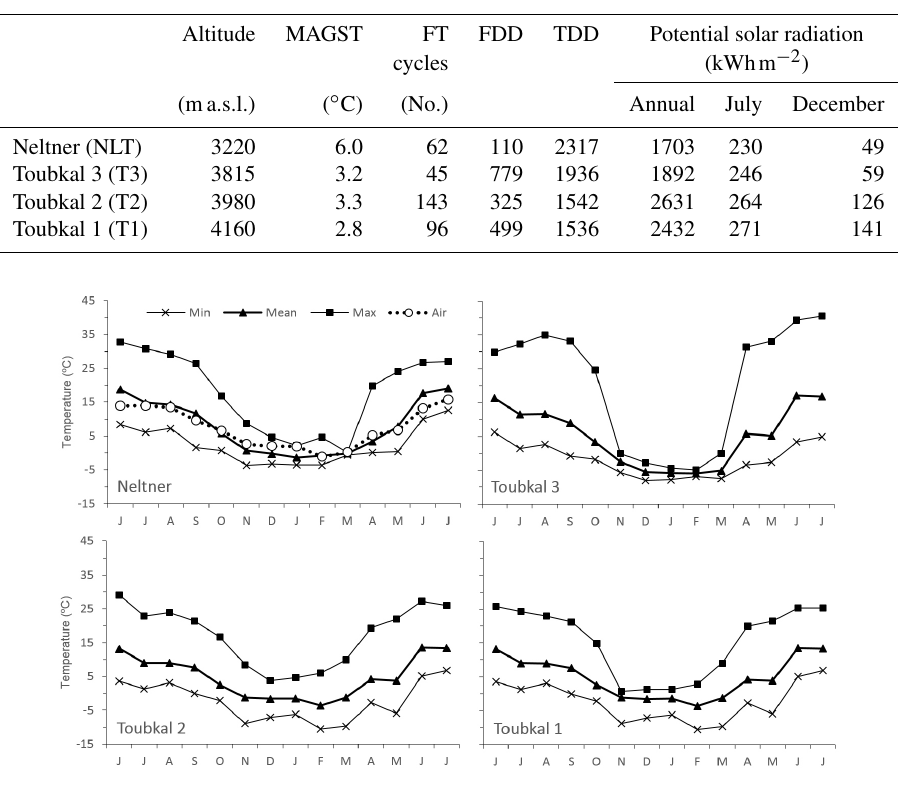
Figure 7. Monthly ground surface and air temperatures in the Djebel Toubkal massif from June 2015 to July 2016. Extremes are absolute monthly maximum and minimum temperatures.